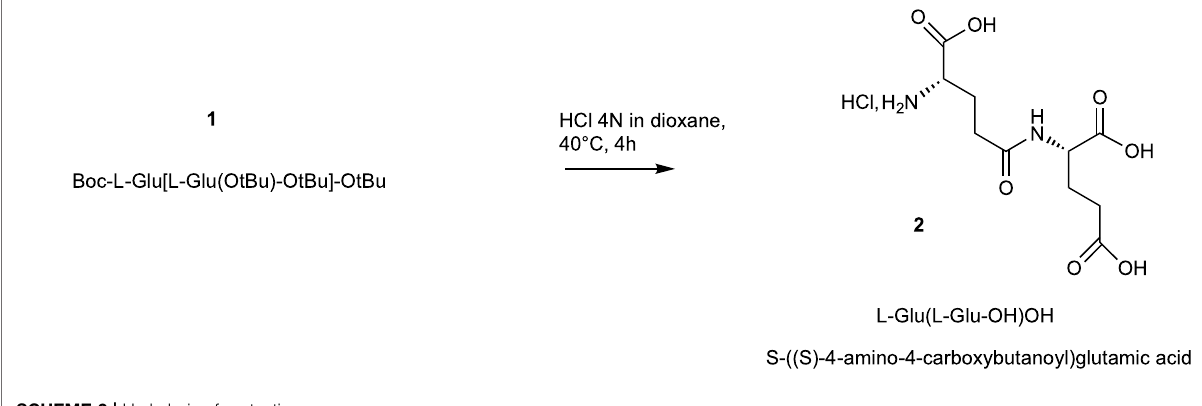
( Figure 2A ). The application of γ -Glu-Glu signi fi cantly and reversibly enhanced the frequency of sEPSC (220 ± 12% of basal frequency; n (cid:1) 3). This excitatory effect was not observed on mEPSCs isolated by applying TTX either in the presence ( n (cid:1) 3) or absence ( n (cid:1) 4) of Mg 2+ ions in the extracellular medium ( Figures 2B,C , respectively). Both the mean amplitude and frequency of appearance were unaffected by γ -Glu-Glu application. This result precludes that presynaptic NMDA receptors are involved in the excitatory effect of γ -Glu- Glu on synaptic transmission. Taken together, these data con fi rmed those obtained by measuring intracellular Ca 2+ changes in the presence of